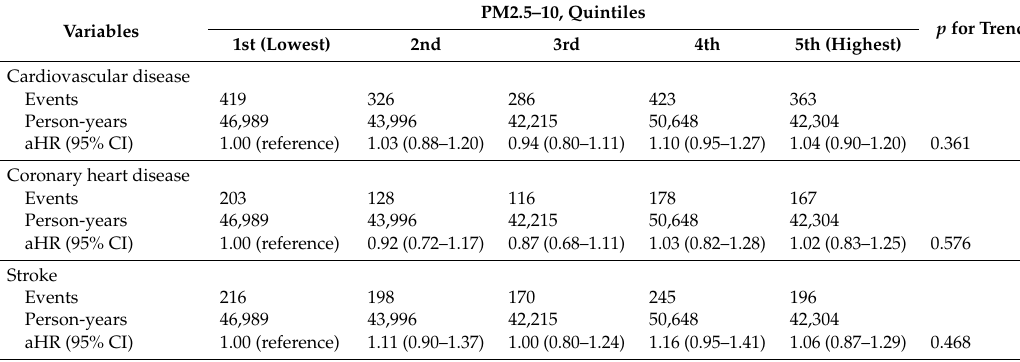
Table 4. Adjusted hazard ratios (95% CI) for cardiovascular disease according to post-diagnosis PM2.5–10 levels among 5-year cancer